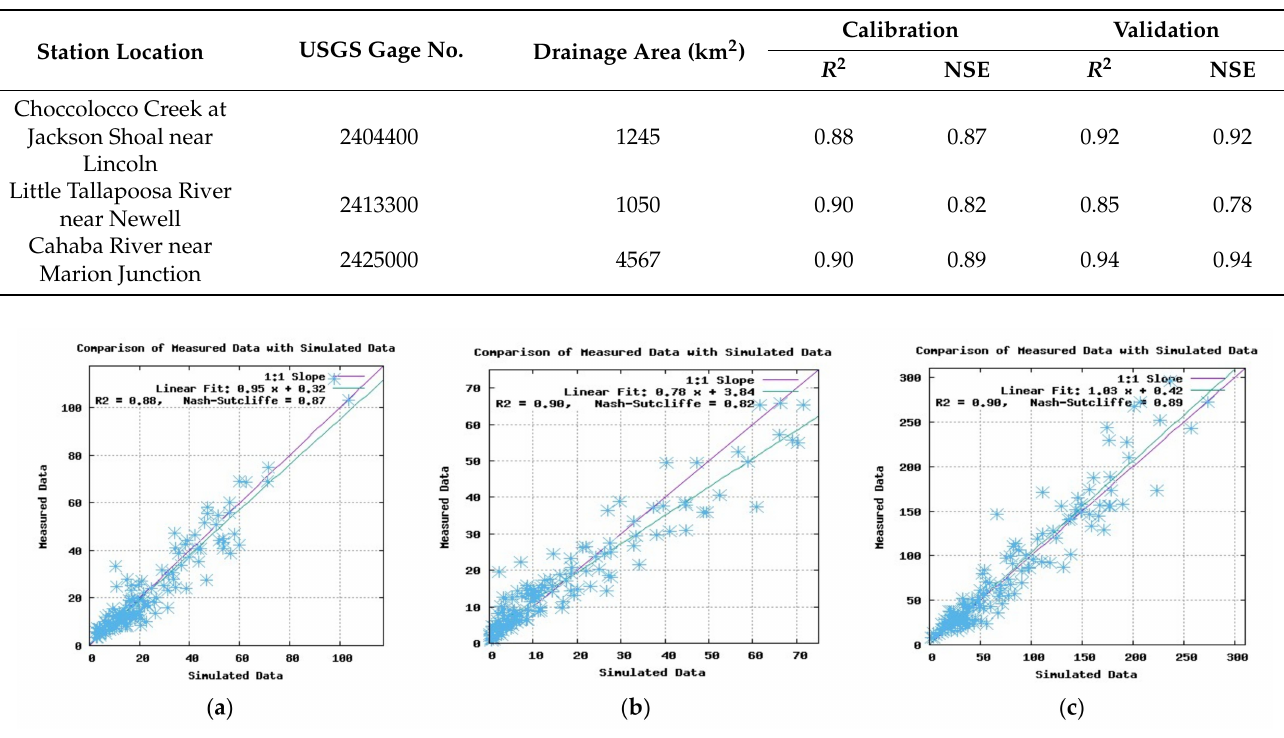
Figure 2. Scatter plot and objective functions for calibration period for ( a ) Choccolocco Creek at Jackson Shoal near Lincoln at USGS Gage 02404400, ( b ) Little Tallapoosa River near Newell near Newell at USGS Gage 24133000, and ( c ) Cahaba River near Marion Junction at USGS Gage